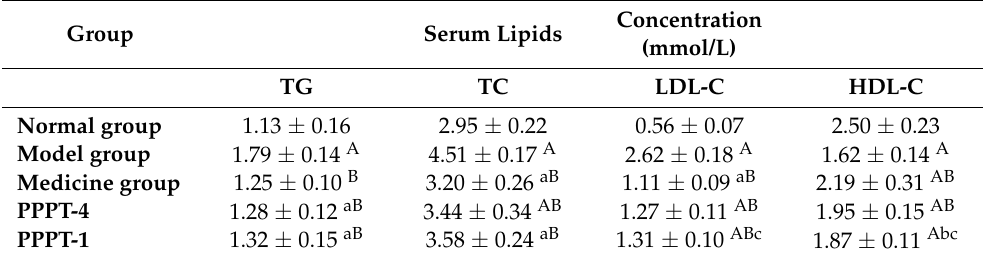
Table 6. Effect of PPPT on TG, TC, LDL-C, and HDL-C of type II diabetic